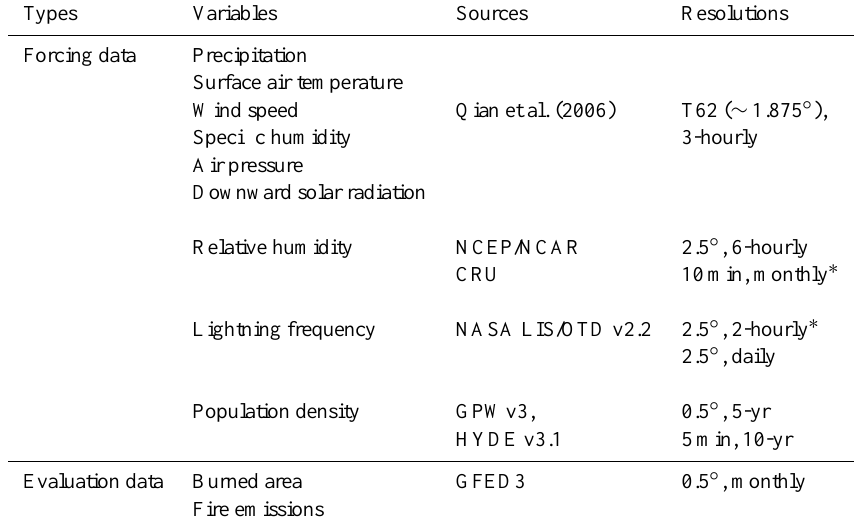
Table 5. Datasets used to drive CLM-DGVM and evaluate simulations.